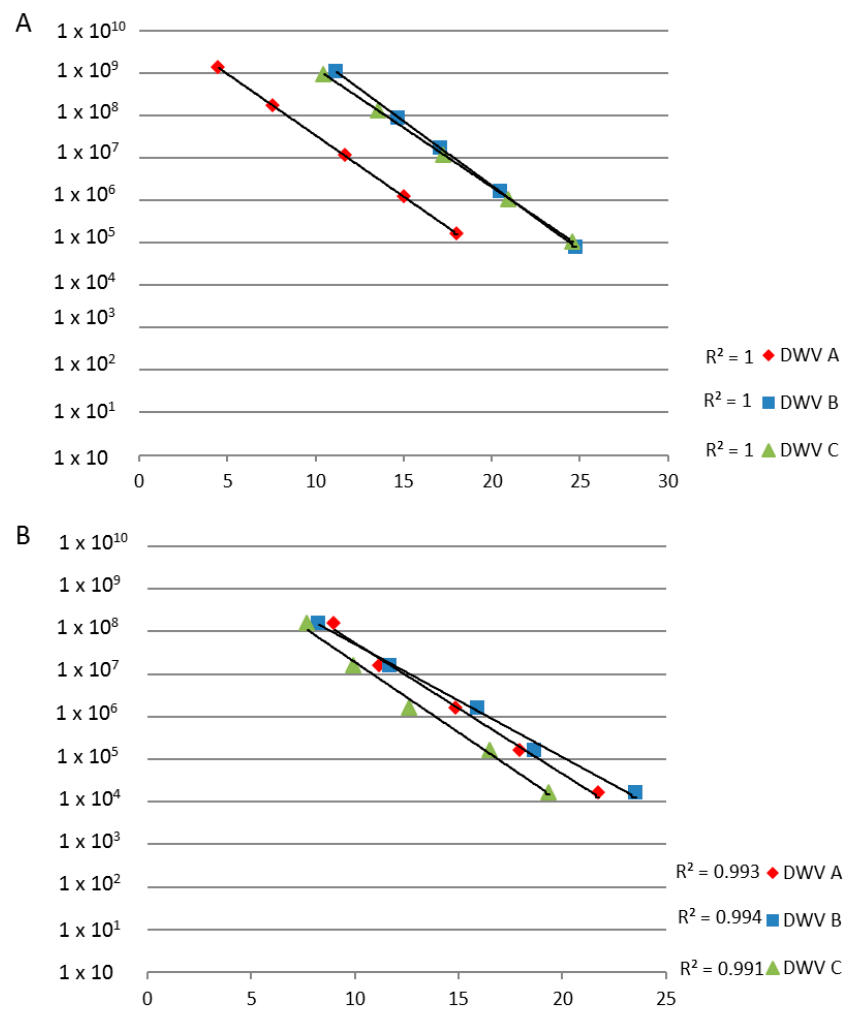
Figure 2. Ten-fold dilution series for cRNA ( A ) and plasmid DNA ( B ) using the RT-PCR and PCR assays; the standard deviation bars are not shown for clarity.